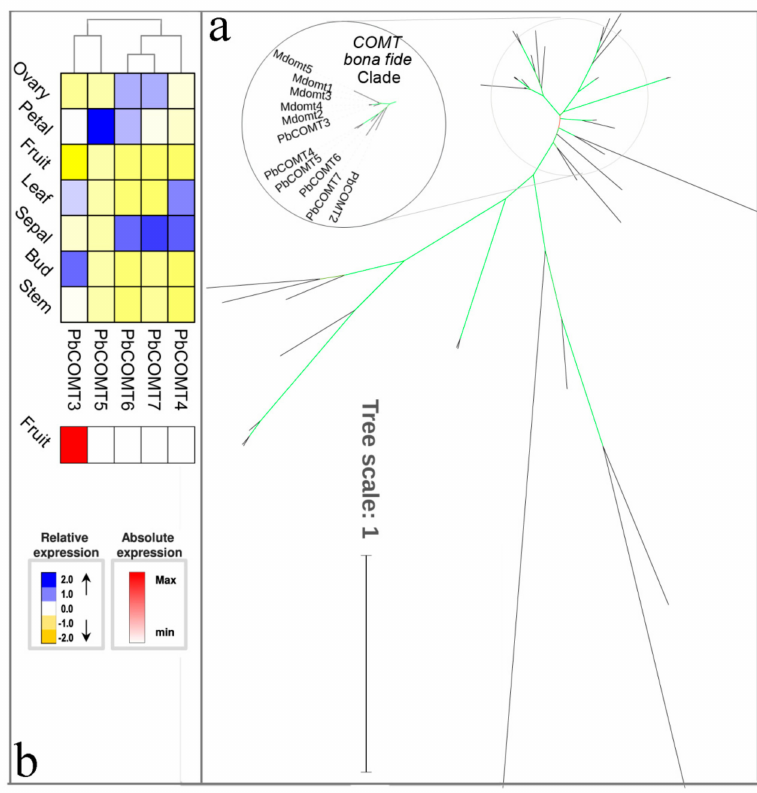
Figure 9. Phylogenetic tree and expression profiles of the COMT bona fide clade. ( a ) ML tree built with COMT bona fide enzymes from several species. ( b ) The expression profiles P. bretschneideri COMT bona fide genes. Subclade containing the bona fide genes is highlighted. The green color of the tree branches suggests strong node support (bootstrap support ≥ 95% and SH-aLRT ≥ 75%). The FPKM values of PbCOMT genes in di ff erent tissues are indicated in Table S3. The gene accession number is indicated in Table S4, Figure S4. The tree scale is the number of amino acid substitution per